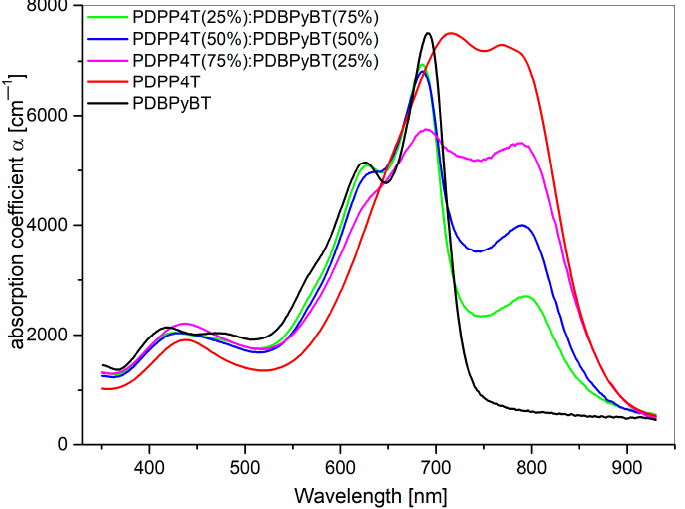
Figure 3. Absorption coefficient of PDPP4T, PDBPyBT films and their blends in the spectral range of visible light. visible